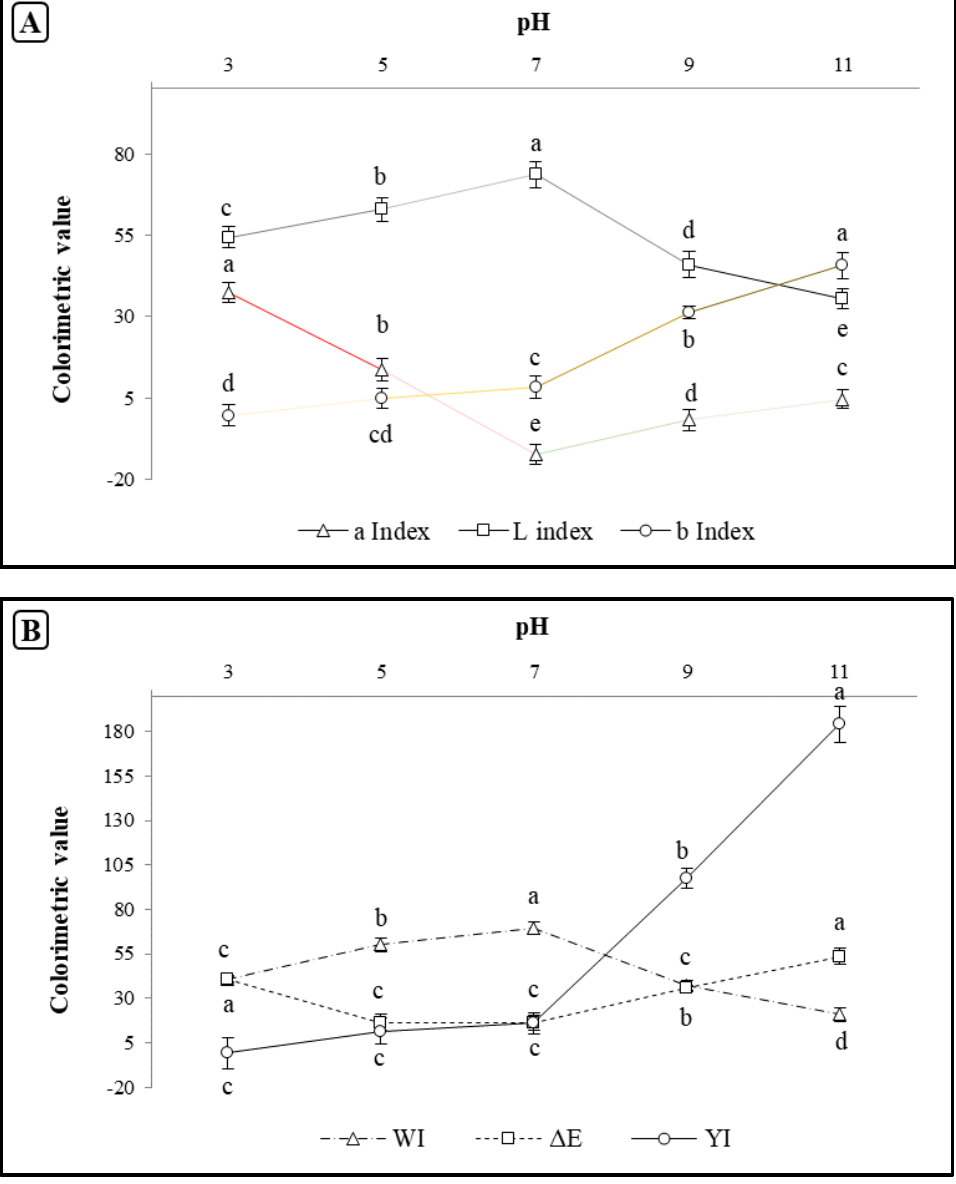
Figure 4. Effect of pH variation on color sensitivity of Salep mucilage edible indicator films (5% v / v SA As ): ( A ) L*, a*, and b* index and ( B ) Δ E, WI, and YI. For each linear graph, means with superscripts (a – e) are significantly different ( p < 0.05). Data are means ± SD.